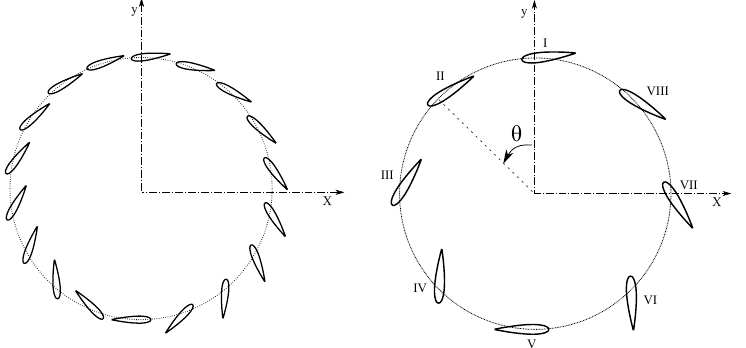
Figure 8. ( left ) Layout of the blade orientations during a period of revolution; ( right ) layout of the blade orientations at the same positions as in Figure